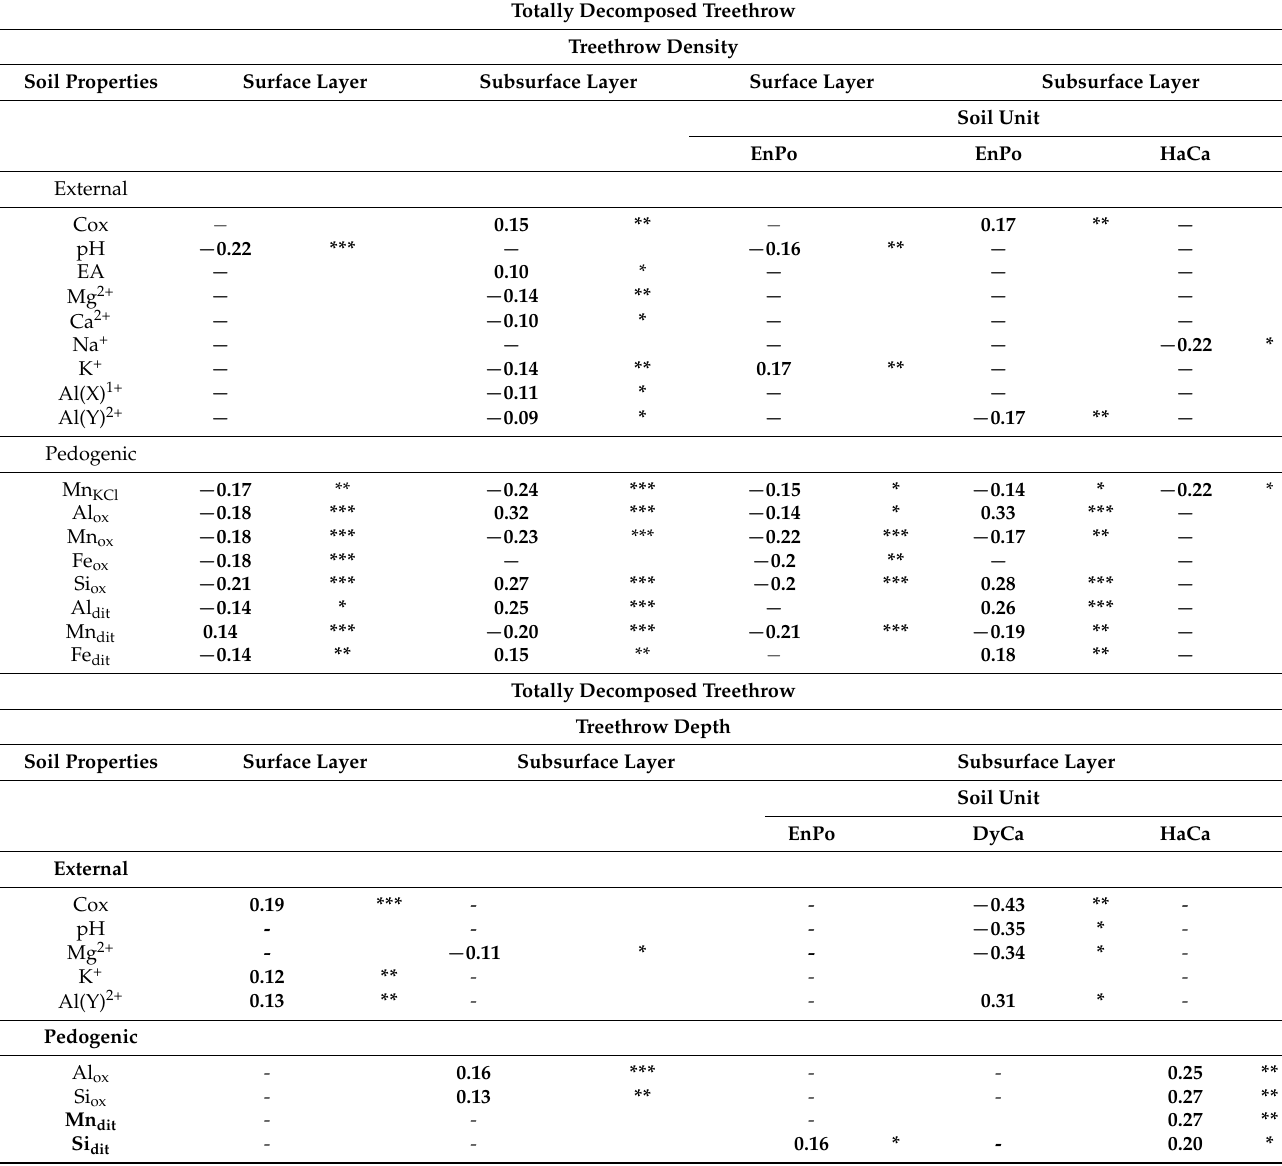
Table 4. Pearson correlation coefficient for the relationship between treethrow density and depth of treethrow and soil chemical properties for totally decomposed treethrow. Significant relation- ships are indicated in bold and marked according to their significance level: *** p < 0.001; ** p < 0.05; * p < 0.1. Note that the relationships shown in the table are significant for treethrow density and depth of treethrow. The soil units analysed are: AlPo-_Albic Podzol, EnPo-Entic Podzol, DyCa- Dystric Cambisol, HaCa-Haplic Cambisol. More information can be found in Table S3 in the Supplementary